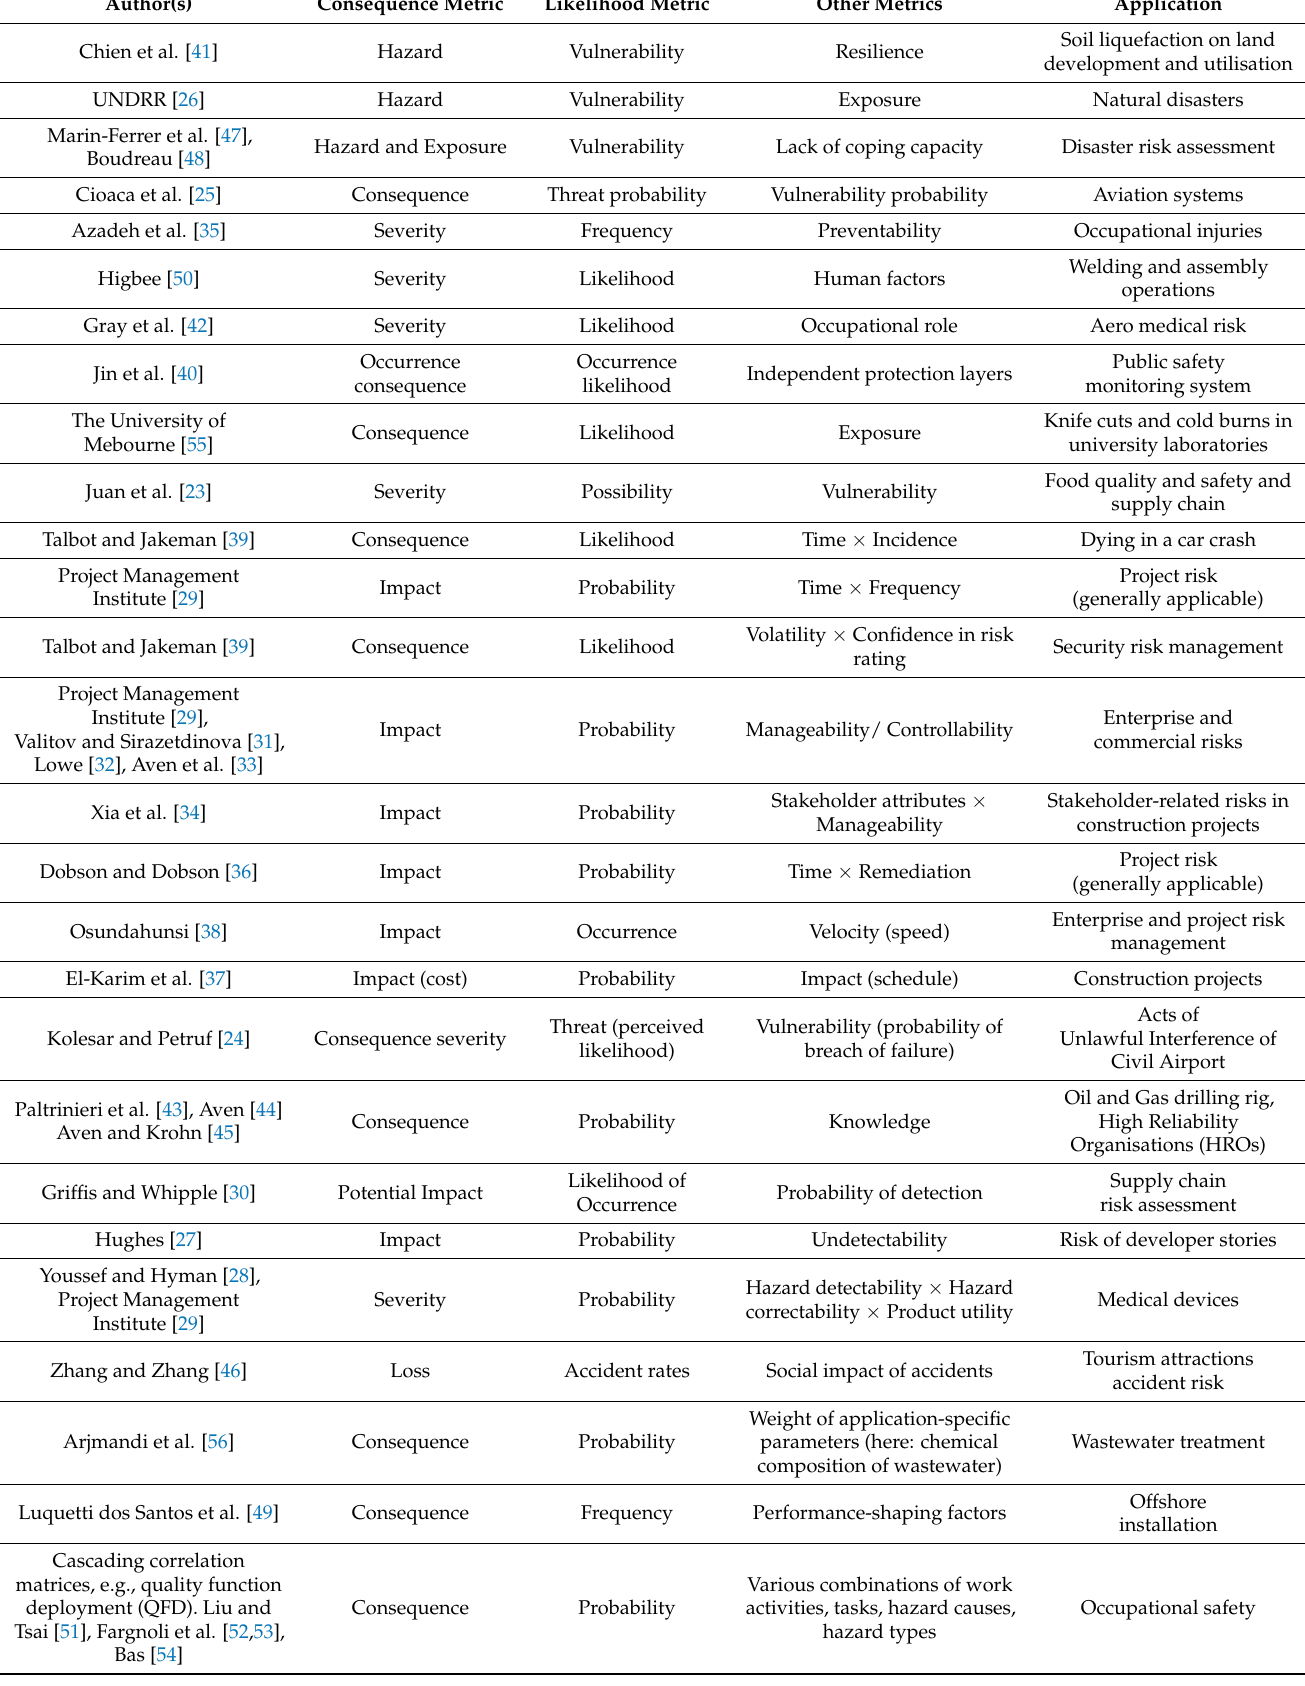
Table 1. Overview of existing approaches that considered other